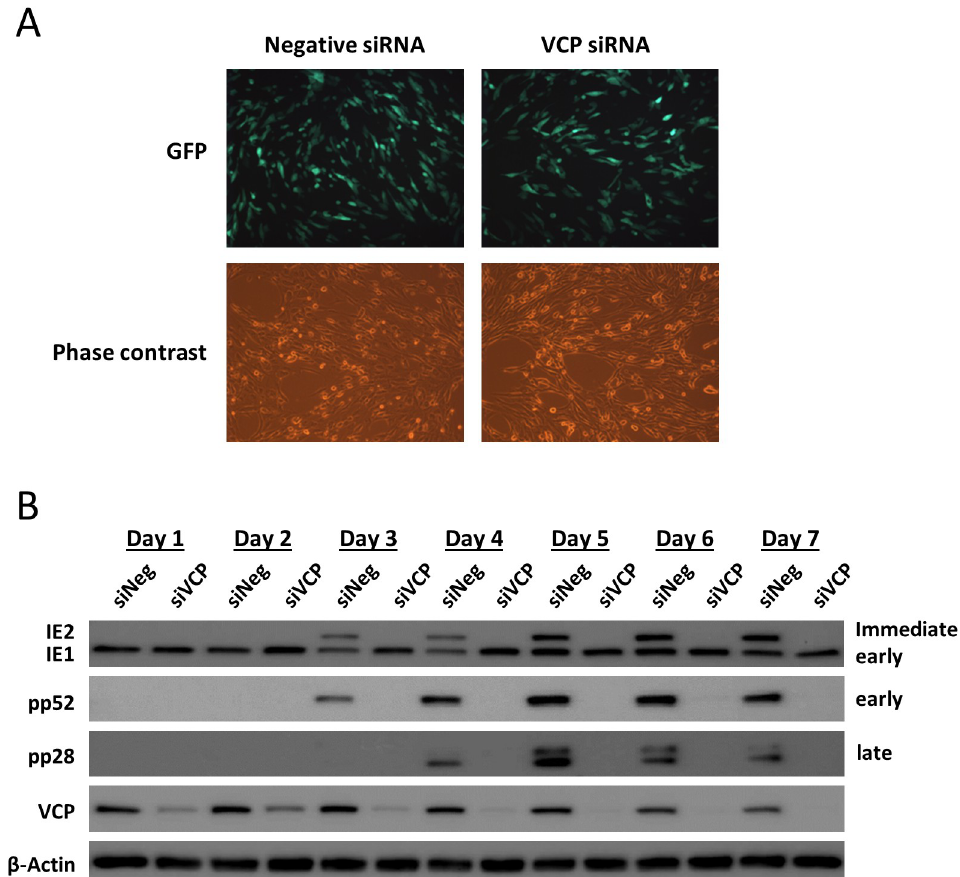
Fig 3. Knockdown of VCP results in a specific loss of the major immediate early protein IE2. (A) Fluorescence microscopy demonstrates that all cells are infected with HCMV at 48 HPI followingtransfection with VCP siRNA, indicatingno major effect on virus entry and translocation to the nucleus.(B) Western blot analysisfor viral proteinsof each major kinetic class shows a clear loss of IE2 expressionand downstream early and late viral